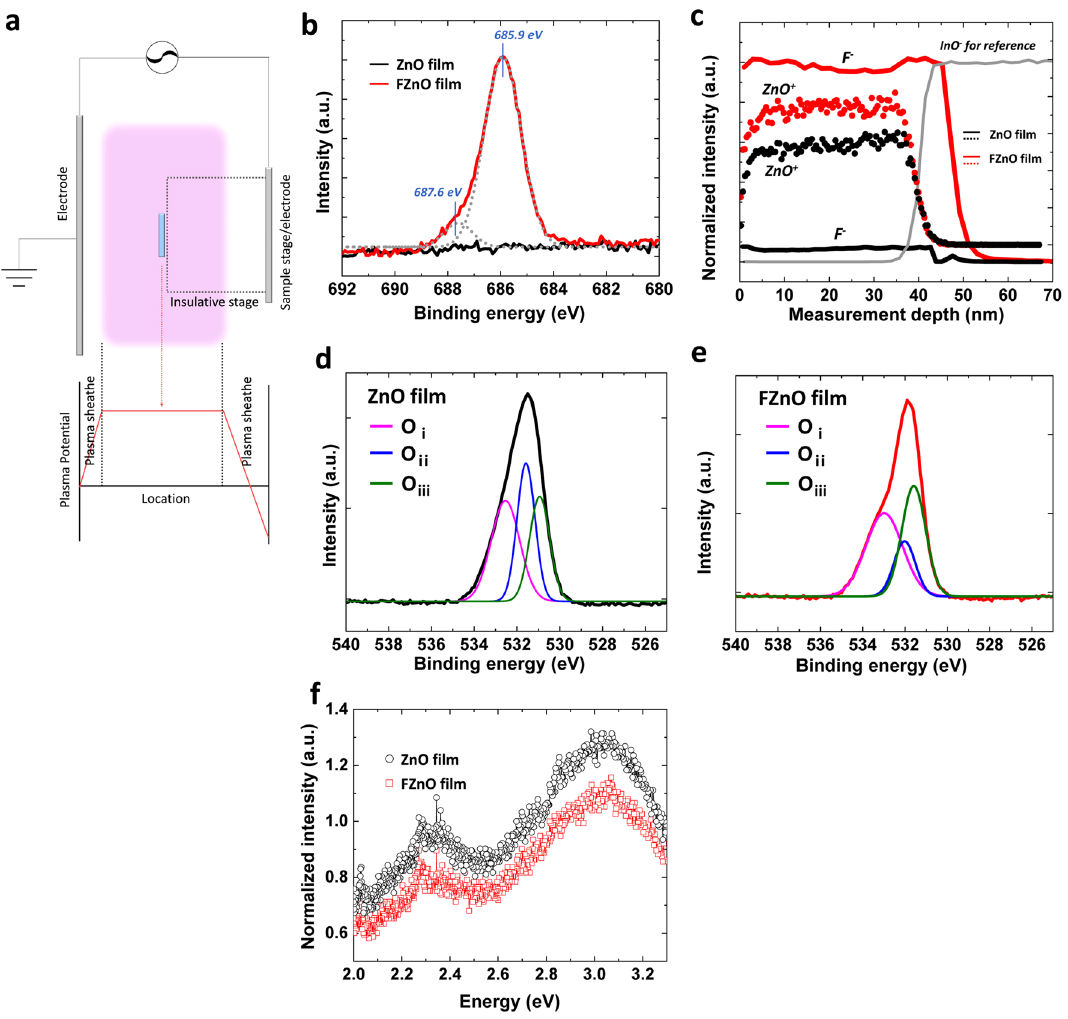
Fig. 1 a Schematic diagram of the plasma treatment setup. XPS spectra of F 1 s core level electrons in b ZnO and FZnO films and c F − and ZnO + . All intensity values of TOF–SIMS are normalized by intensity of InO − signal. O 1 s core level electrons in d ZnO film and e FZnO film. f Steady state PL spectra under 330 nm UV excitation collected from the ZnO and FZnO